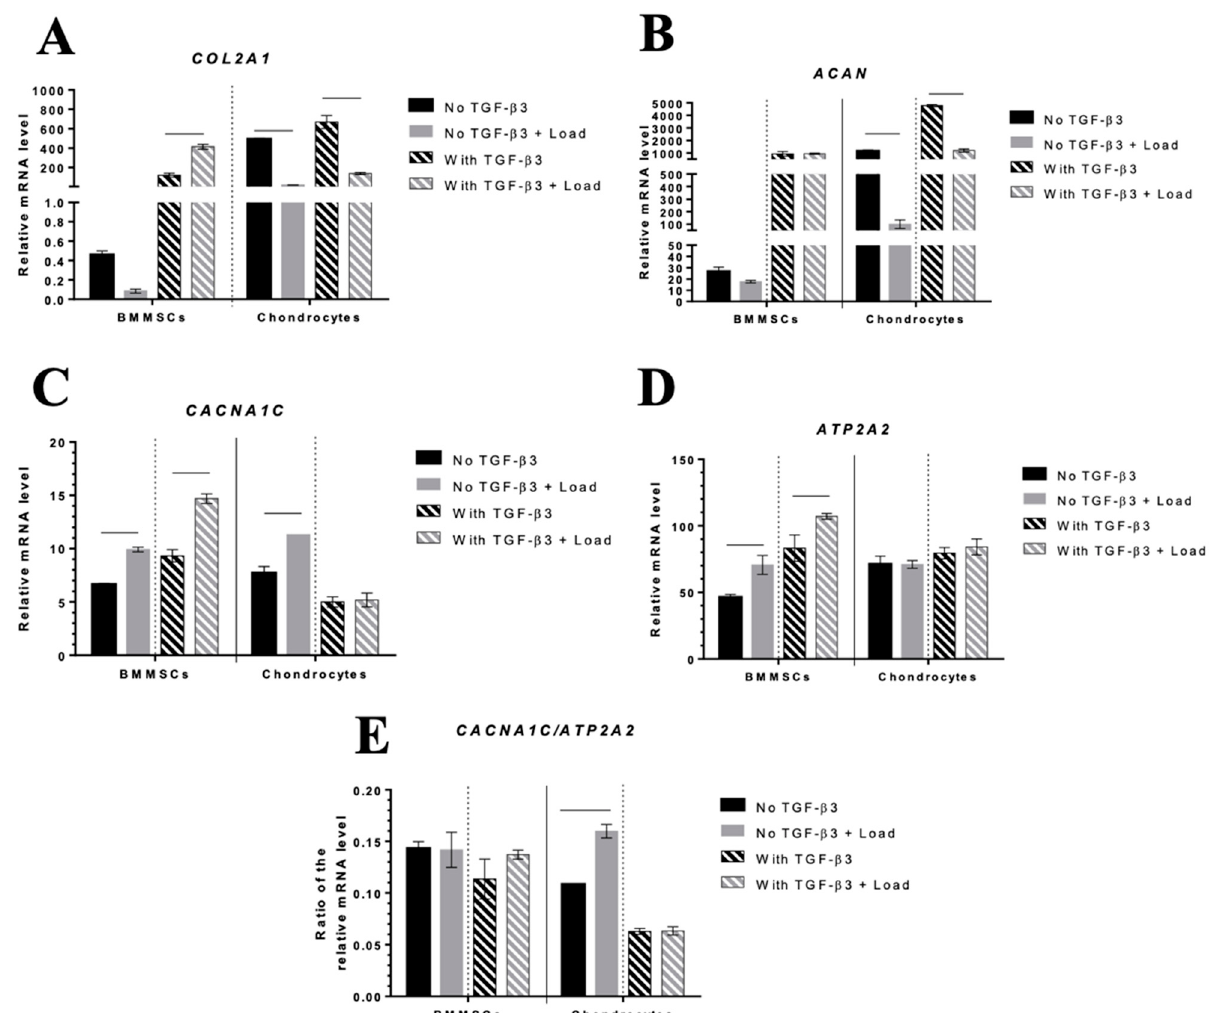
Figure 8. The effect of TGF- β 3 and mechanical load on CS-Tyr/Gel/BMMSCs and CS-Tyr/Gel/chondrocytes composites. The expression of chondrogenic differentiation-related markers, ( A ) collagen II (COL2A1) , ( B ) aggrecan (ACAN) , and iCa 2+ regulators, ( C ) L-type channel subunit CaV1.2 (CACNA1C) and ( D ) Serca2 pump (ATP2A2), were analyzed on 21 st day of chondrogenic differentiation with/without TGF- β 3 (10 ng/mL) and mechanical load, as described in the Methods section. ( E ) Ratio of CACNA1C/ATP2A2 . Data are shown as mean ± SD from three repeats of two BMMSC and chondrocyte cell cultures and are significant at p ≤ 0.05 (horizontal bars). The cells were cultivated in chondrogenic medium with or without TGF- β 3 and mechanical load. Gene expression was normalized with B2M and RPS9 housekeeping genes.